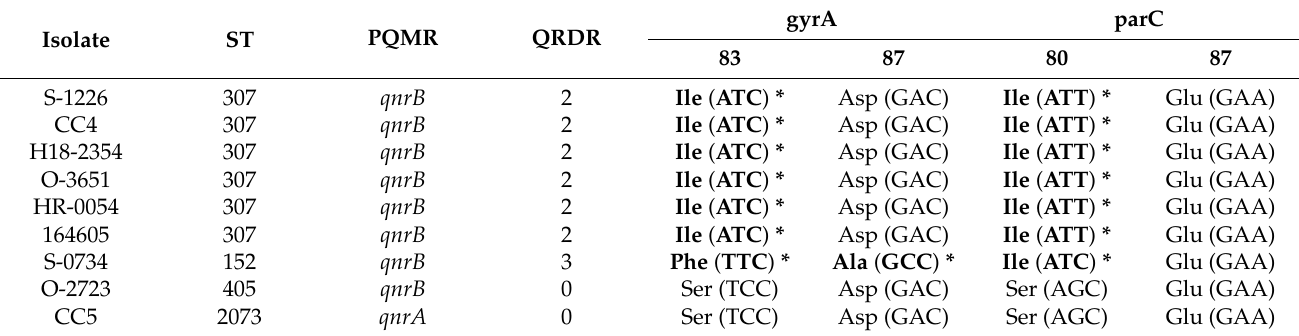
Table 3. Distribution by ST of QRDR and PMQR genes in isolates resistant to quinolones.